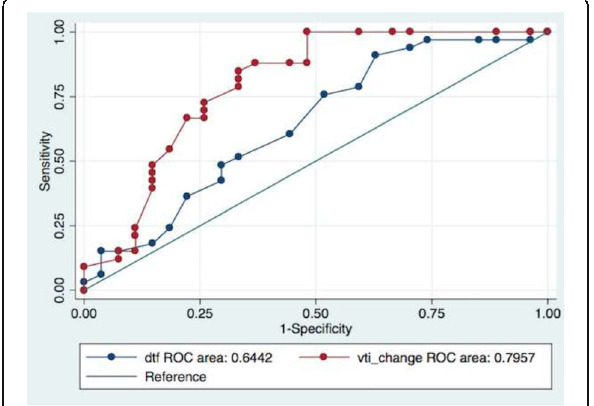
Fig. 1 (abstract 0053). AUROC curve for Diaphragmatic Thickness Fraction and VTI change to